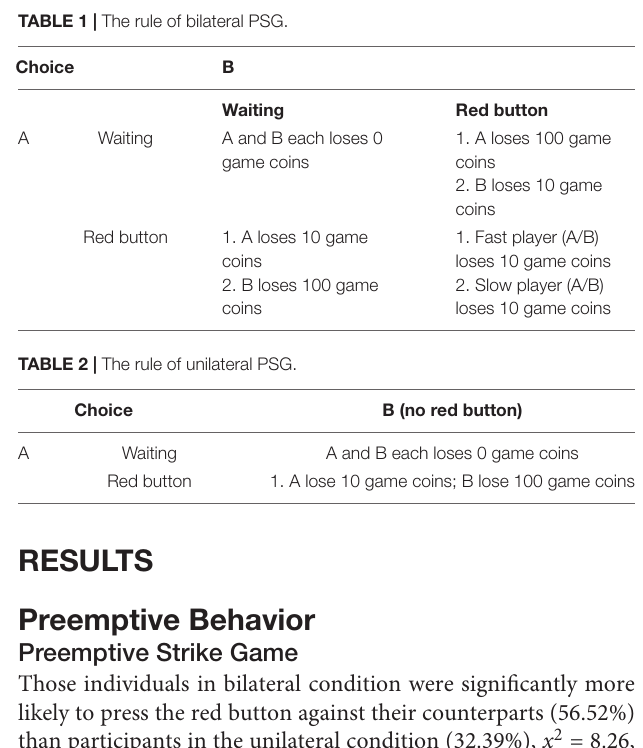
TABLE 1 | The rule of bilateral PSG.